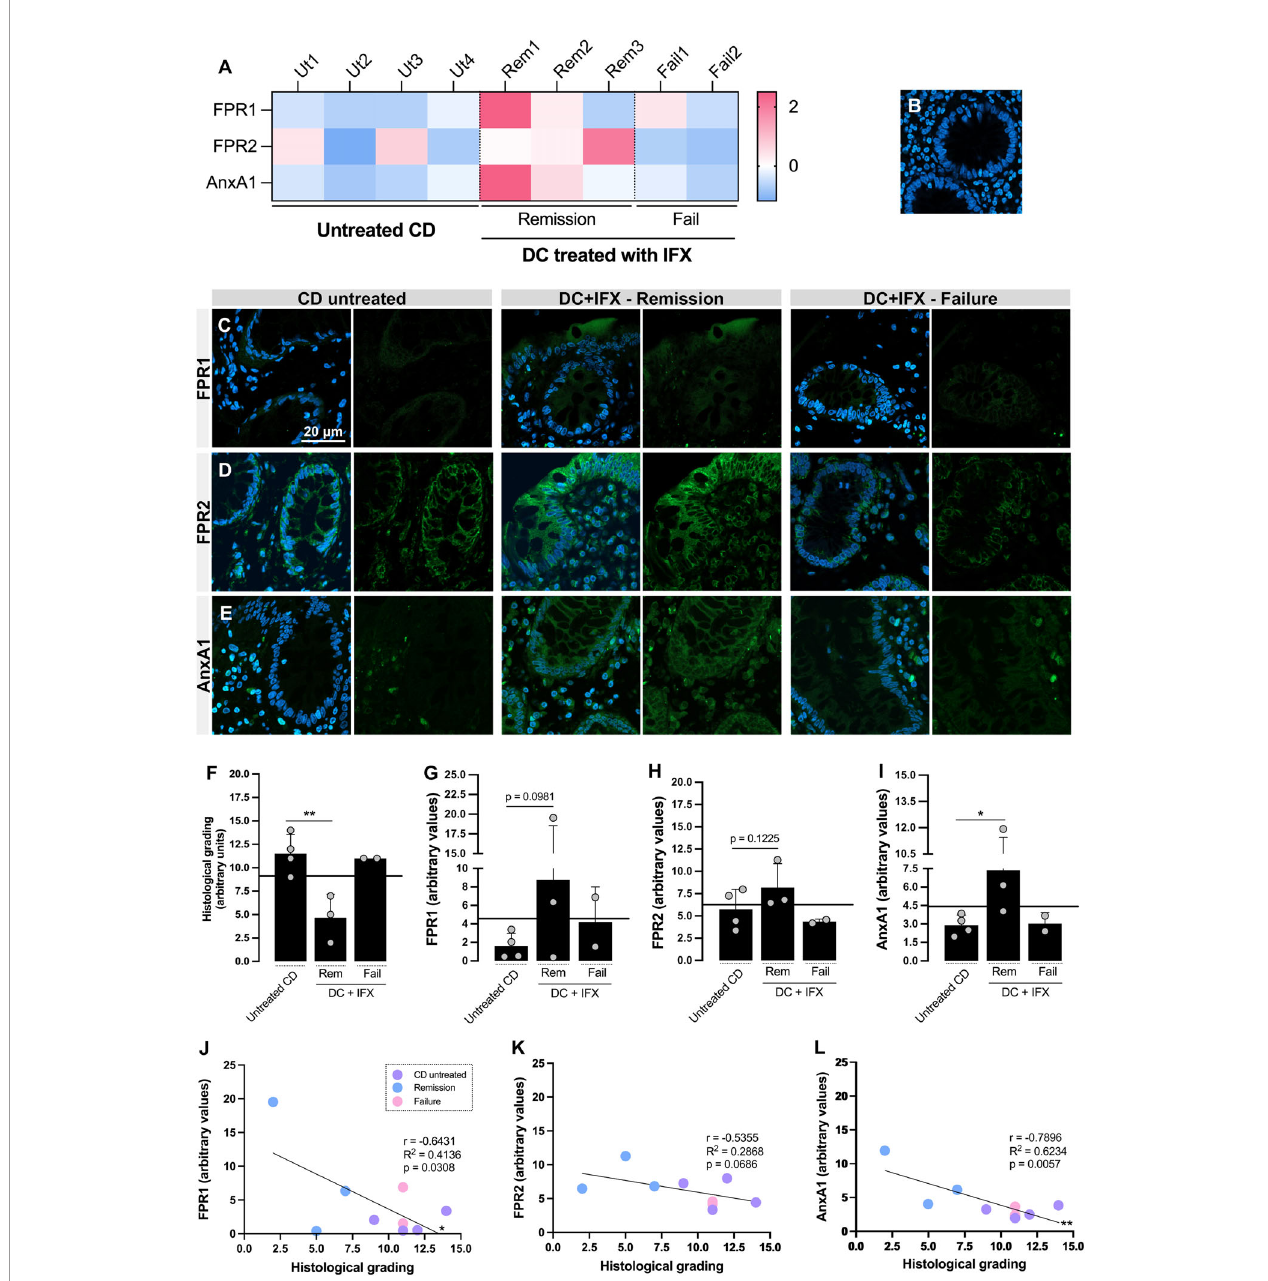
FIGURE 1 | Formyl peptide receptor 1 (FPR1), FPR2, and annexin A1 (AnxA1) are differentially expressed in the colon of Crohn ’ s disease (CD) responders to in fl iximab (IFX) and correlate with histological homeostasis. (A) Heatmap based on the Z -scores of FPR1, FPR2, and AnxA1 expression values in the colon. (B – E) Confocal imaging: negative control of reaction (B) , FPR1 (C) , FPR2 (D) , and AnxA1 (E) tissue staining. Embedding, paraf fi n; sections, 3 m m. Bar , 20 m m. (F) Histological grading, calculated based on Supplementary Table 1 . (G – I) Densitometric analysis of fl uorescence: FPR1 (G) , FPR2 (H) , and AnxA1 (I) . (J – L) Correlation analysis between histological grading of biopsies and fl uorescence intensity of staining: FPR1 (J) , FPR2 (K) , and AnxA1 (L) . * p < 0.05, ** p < 0.01. n = 4 (CD untreated); n = 3 (Remission); n = 2 (Failure). Results are expressed as the mean ±